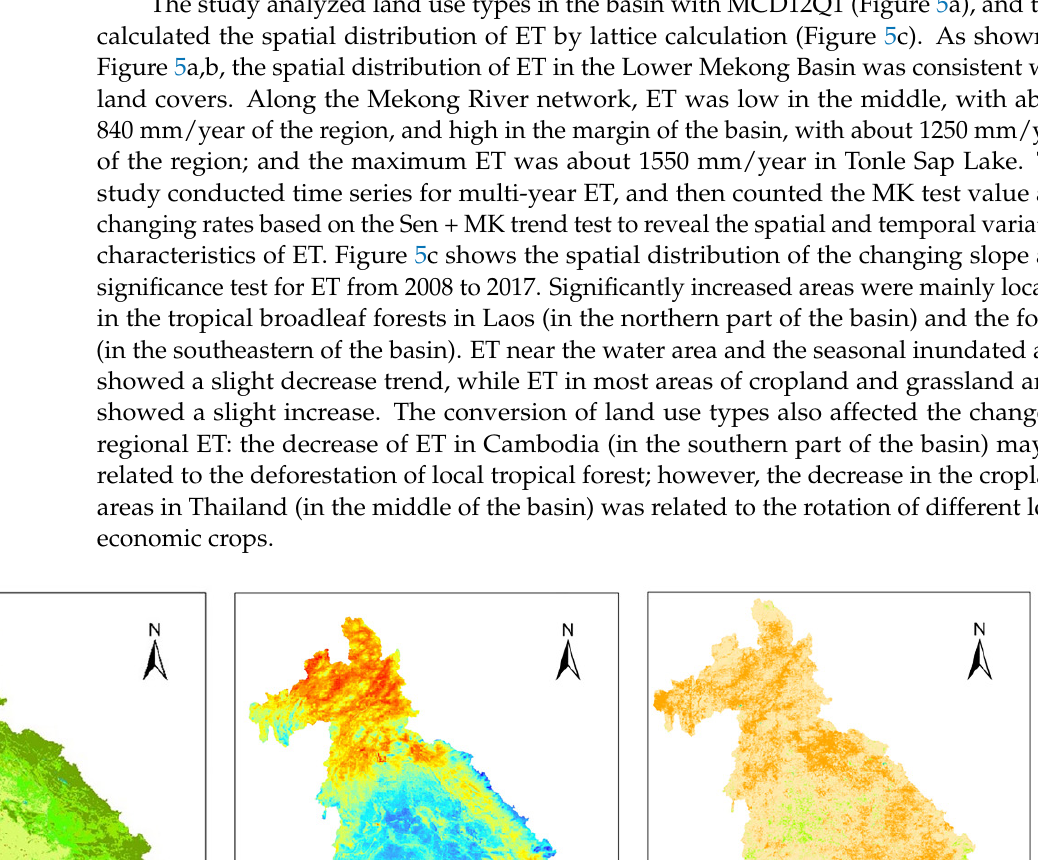
Figure 4. Temporal variation trend of ET. ( a ) The inter-annual trend of annul ET and precipitation from 2008 to 2017. ( b ) The rainy season ET and the dry season ET from 2008 to 2017. ( c ) The monthly trend of ET and precipitation from 2008 to 2017.